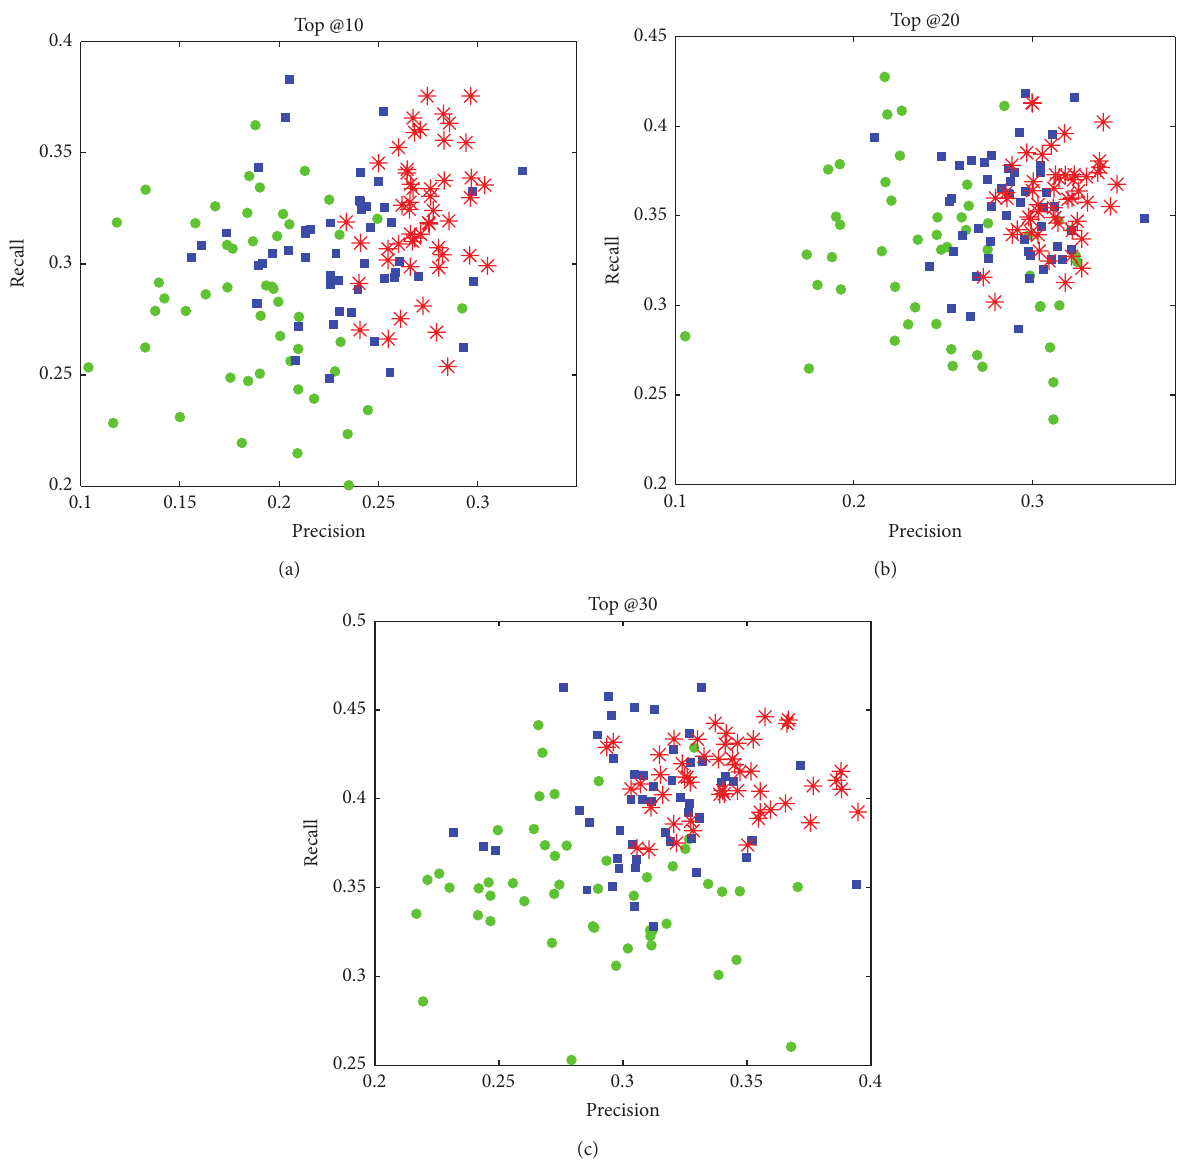
Figure 9: Precision-recall plot of different recommendations. Remark. ∘ (green) denotes the bandit-based recommender; ◻ (blue) denotes the SCENE recommender; and ∗ (red) represents